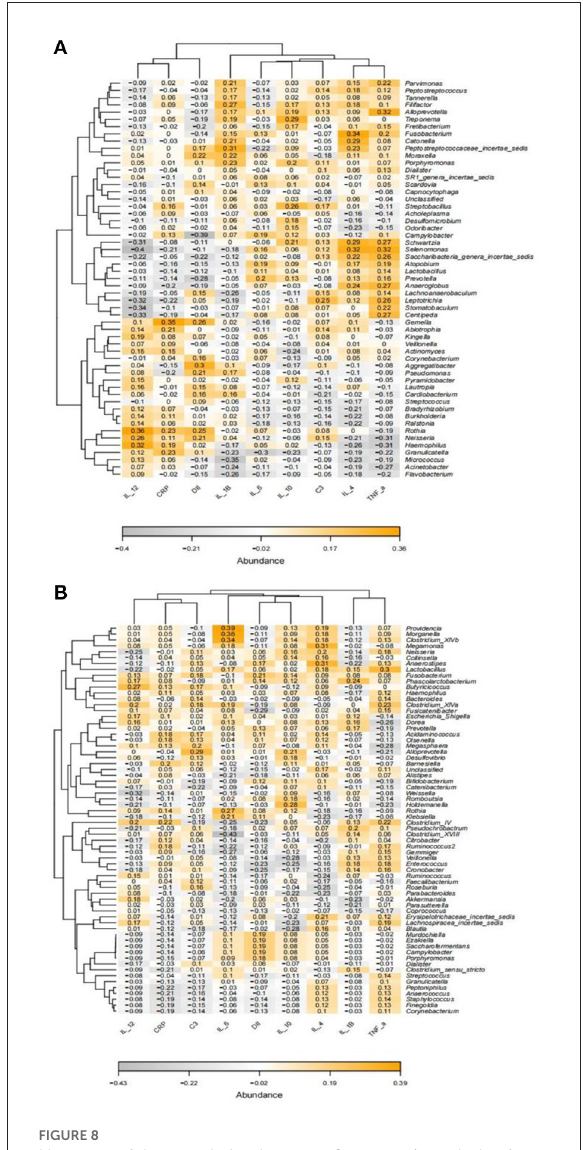
FIGURE8 Heatmap of the correlation between Spearman’s analysis of inflammatory markers and the relative abundance of oral (A) and gut microbiota (B) at the genus level. Orange and gray represent positive and negative correlations, respectively, with color intensity proportional to the degree of association between indices, and numbers represent r values.